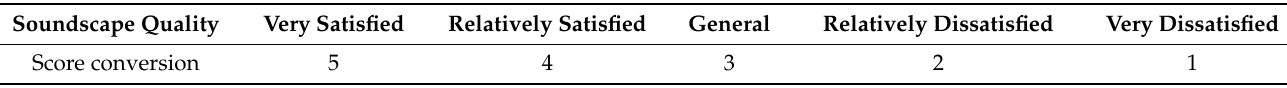
Table 4. Overall assessment of open-plan studio’s sound